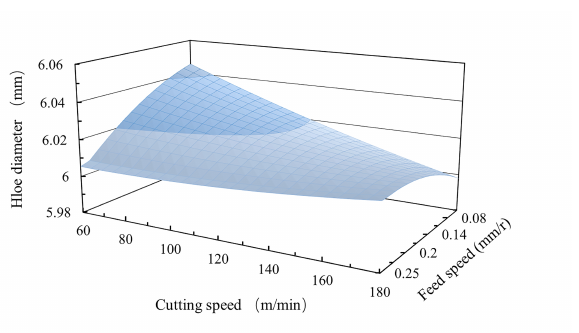
Fig. 9. Results of hole